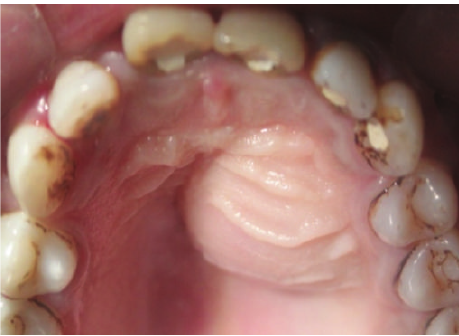
Figure 4: Pre-operative CBCT image in coronal plane showing presence of a large periapical lesion.